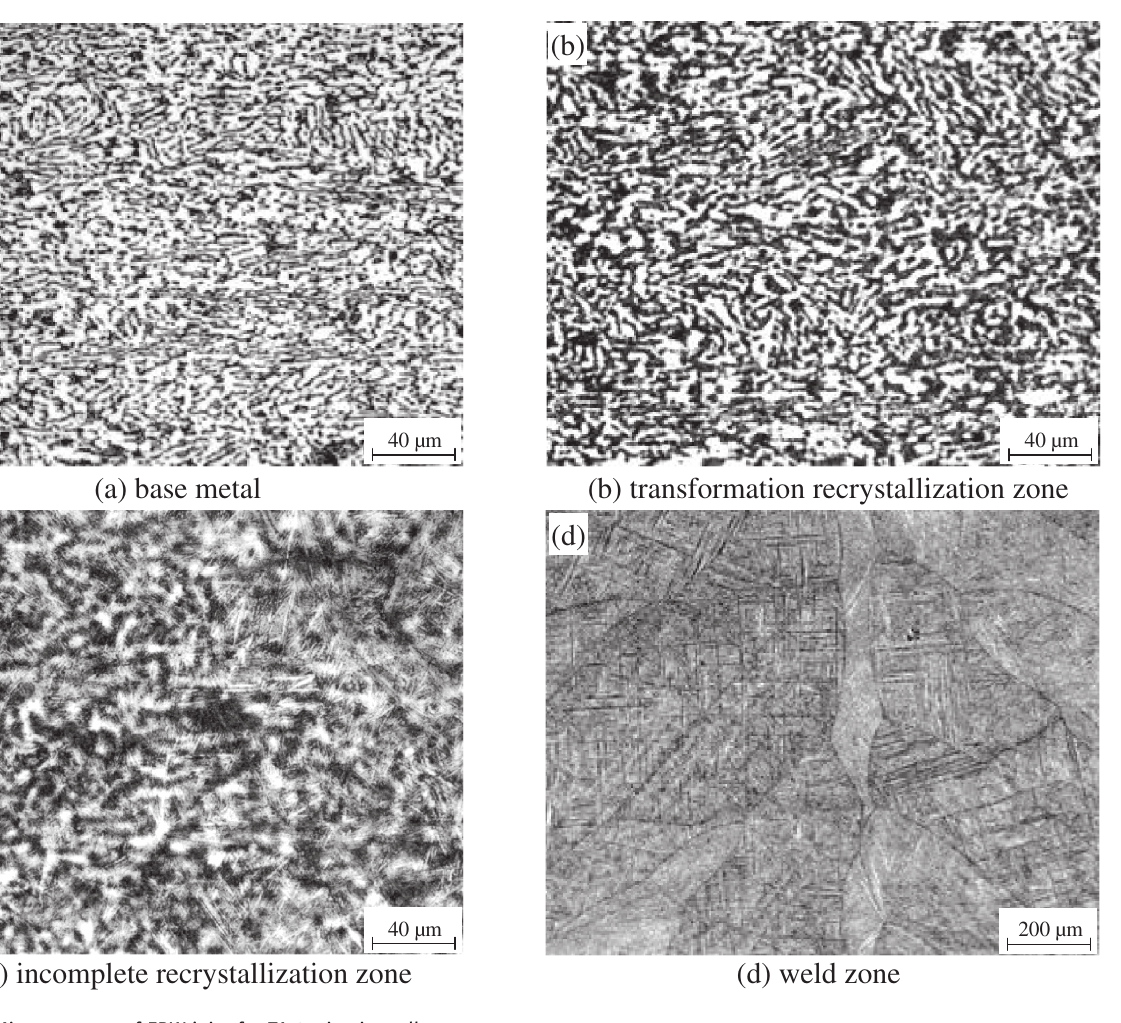
Figure 3: Microstructure of EBW joint for TA 15 titanium